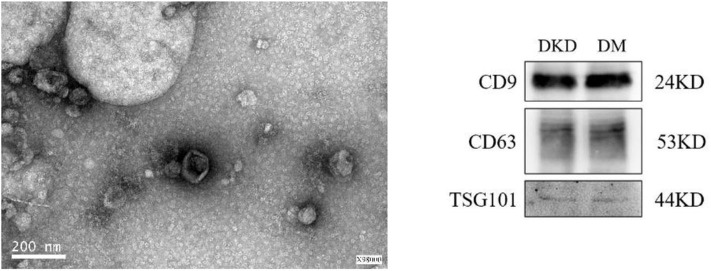
Exosomes under electron microscope; the characterization exosomes with related-markers.